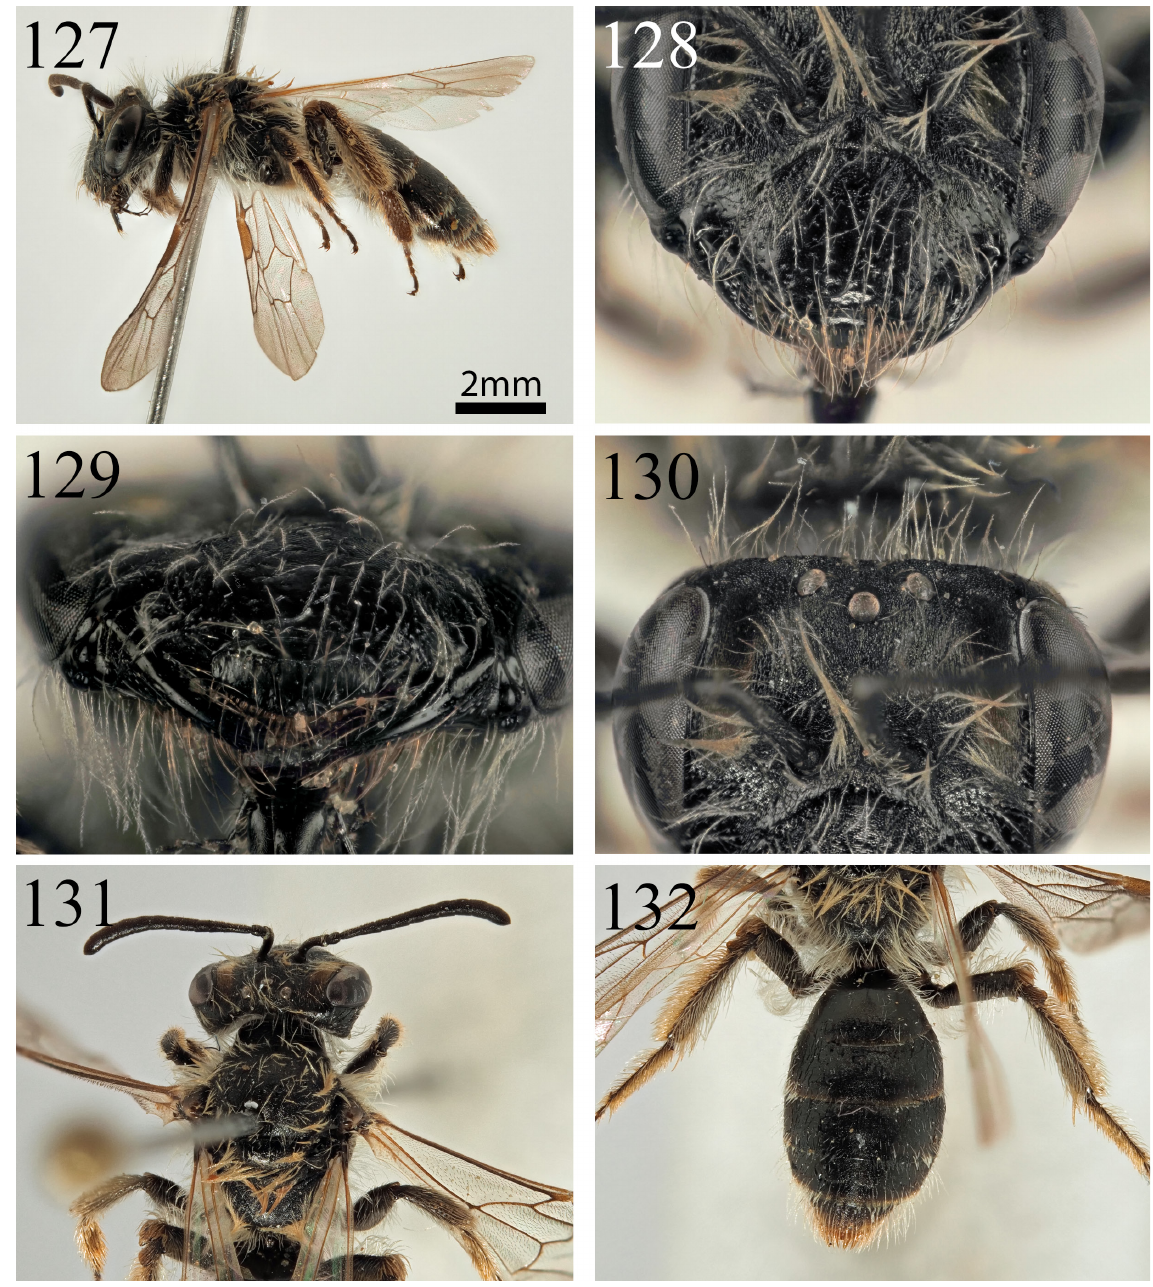
Figs 127–132. Andrena rostamiae sp. nov., ♀ (OÖLM) . 127 . Profile. 128 . Face. 129 . Process of labrum. 130 . Frons, foveae, and ocellar triangle. 131 . Dorsum. 132